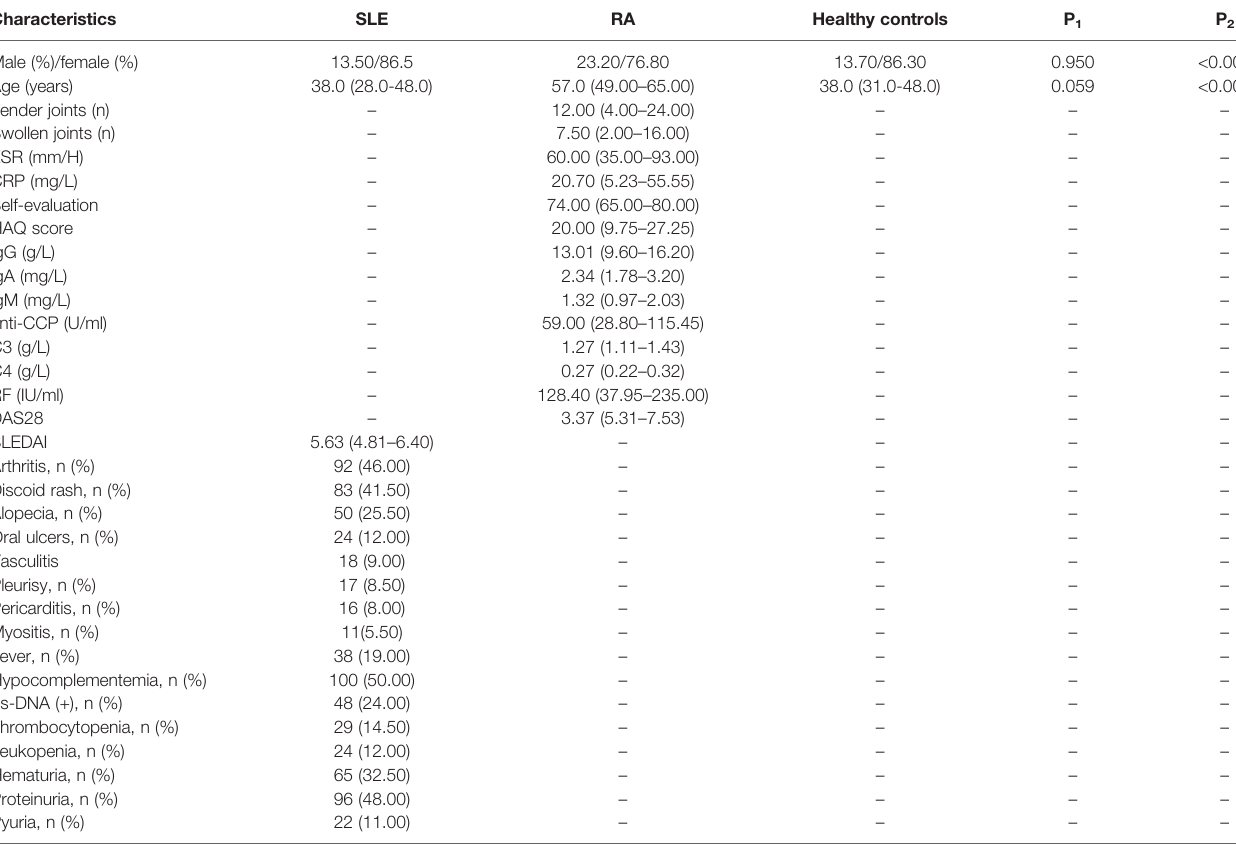
TABLE 1 | Characteristics of patients and controls.